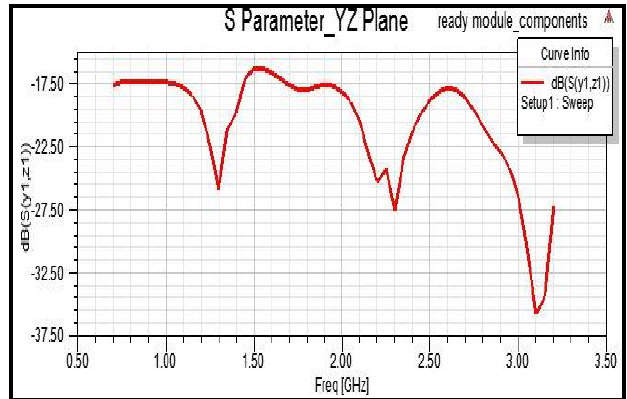
Figure 7: Proposed HFSS module of 3-Axis crossed dipole array.